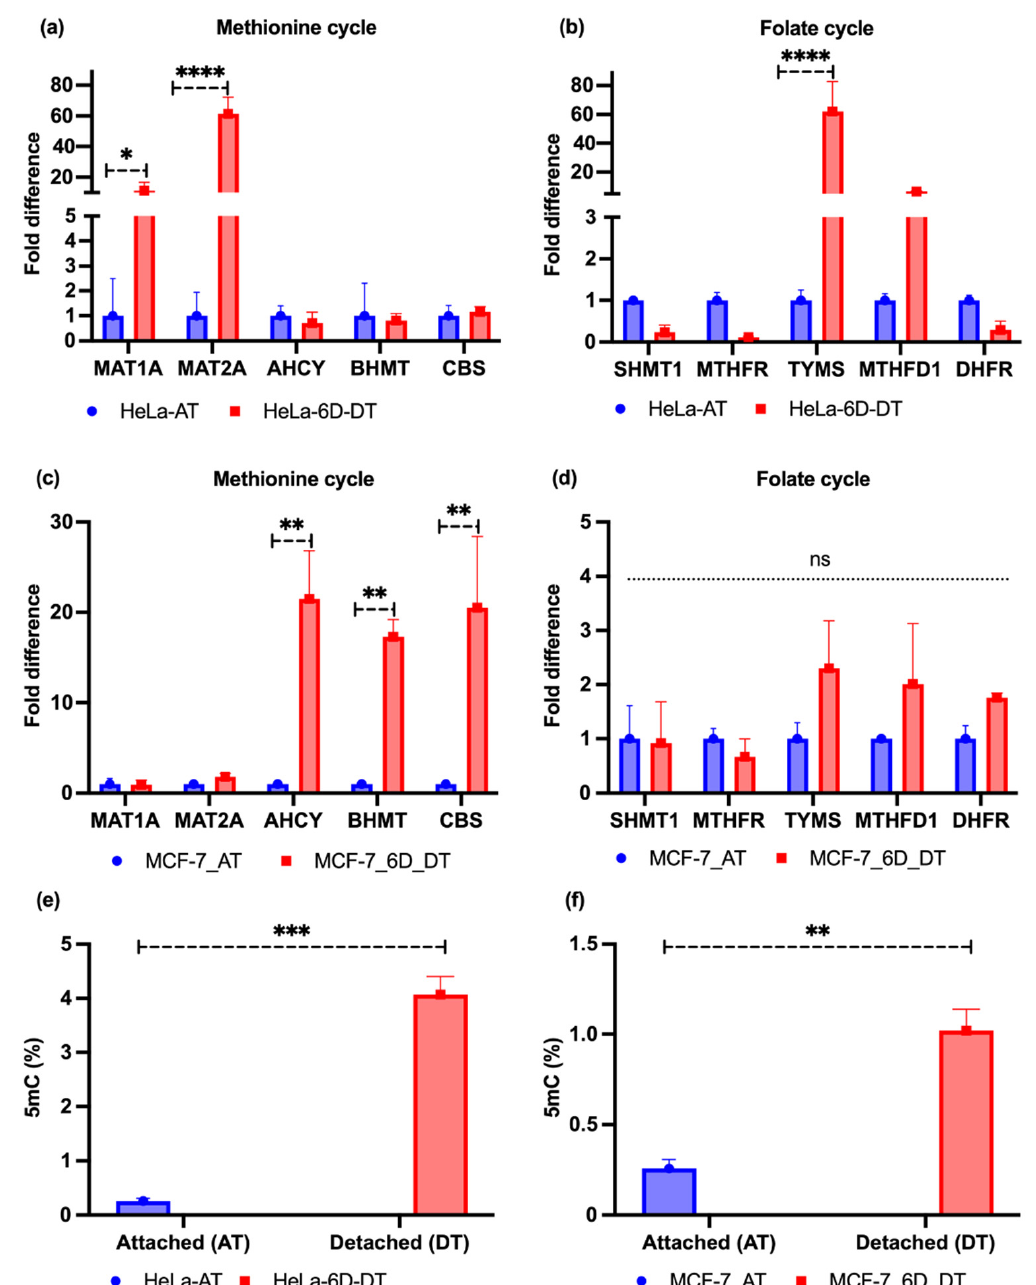
Figure 2. One-carbon metabolic genes and 5mC levels (%) in ECM-attached and -detached condi- tions. ( a ) The mRNA expression levels of one-carbon metabolic genes in the attached (AT) methio- nine cycles and 6 days detached (6D_DT) conditions in the HeLa cell lines. ( b ) The mRNA expres- sion levels of one-carbon metabolic genes in folate cycles in attached (AT) and 6 days detached (6D_DT) conditions in the HeLa cell lines. ( c ) The mRNA expression levels of one-carbon metabolic genes in methionine cycles in attached (AT) and 6 days detached (6D_DT) conditions in the MCF-7 cell lines. ( d ) The mRNA expression levels of one-carbon metabolic genes in folate cycles in attached (AT) and 6 days detached (6D_DT) conditions in the MCF-7 cell lines. SHMT1, serine hydroxyme- thyltransferase 1; MTHFR, methylenetetrahydrofolate reductase. ( e , f ). HeLa and MCF-7 cell lines showed increased 5mC levels in the 6 days (6D_DT) ECM-detached condition compared to the at- tached (AT) condition. The data are presented as mean ± SEM; * p < 0.05, ** p < 0.01, *** p< 0.001, and **** p < 0.0001.